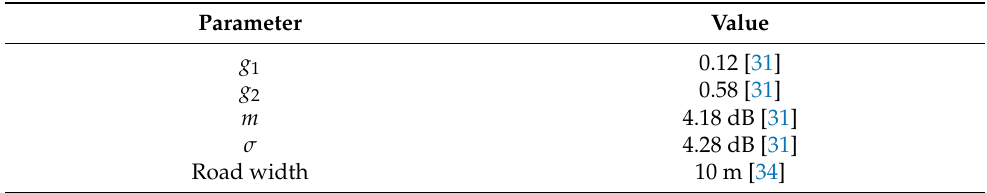
Table 1. Parameters for the simulation scenario.